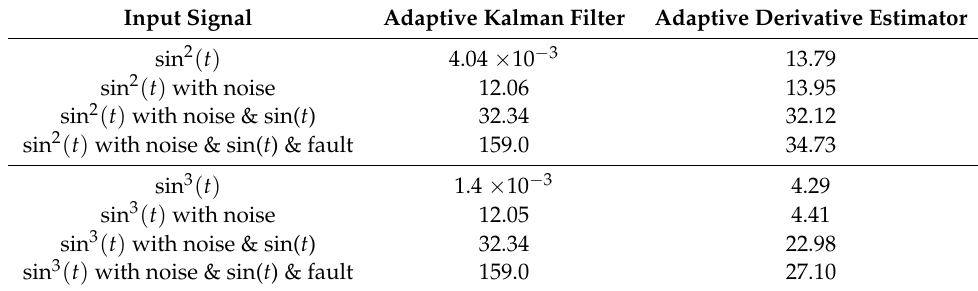
Figure 12. Detailed representation of the high-frequency part of the chirp input signal and its estimations from Figure 10. Table 1. Overview of the estimation errors of different input signals y ( t ) using the Euclidean